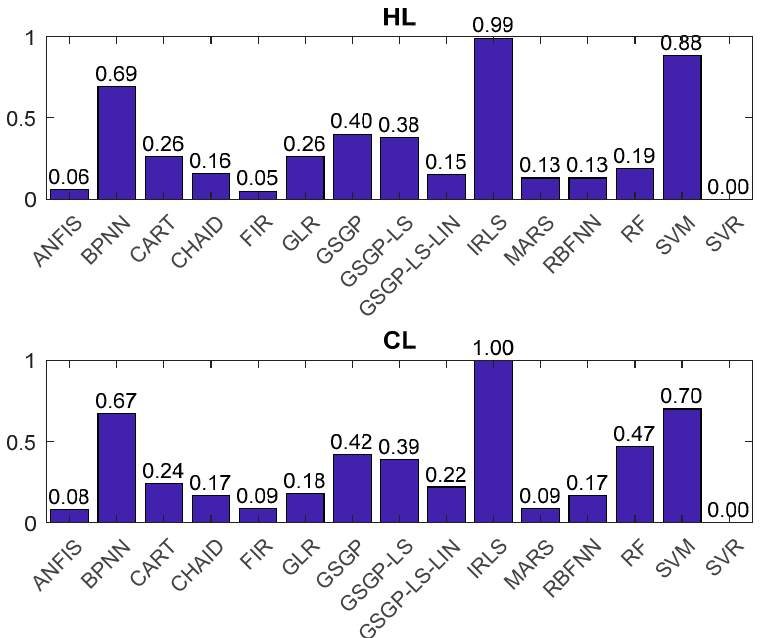
Figure 9. Synthesis indices (SI) of all machine learning methodologies for the heating load (top figure) and the cooling load (bottom figure). Values lower than 0.1 correspond only to SVR, ANFIS and FIR.